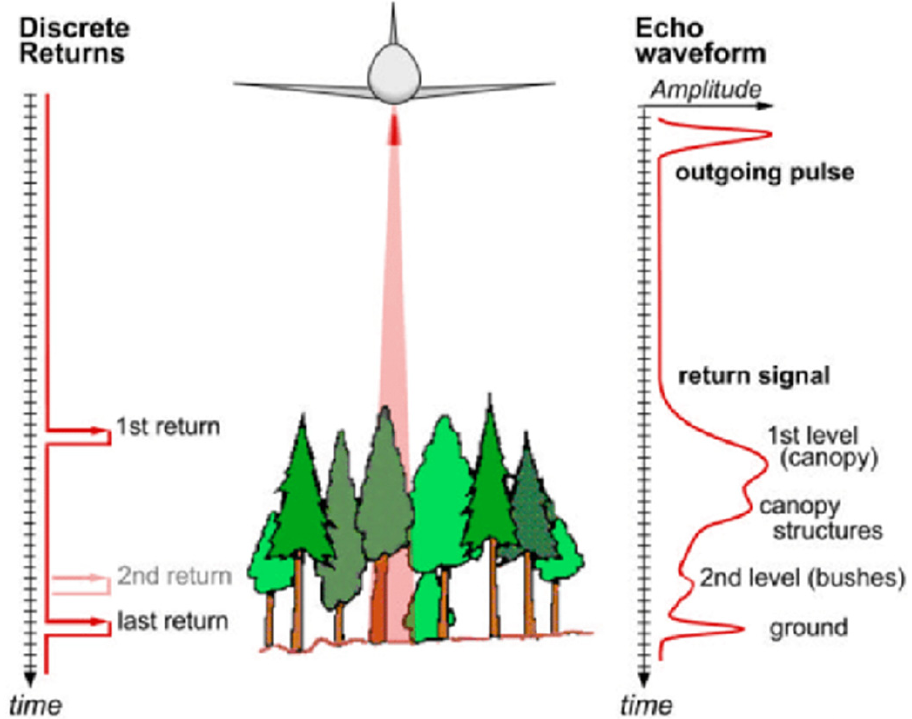
Figure 1. Illustration of laser beam outgoing and return signals (discrete and full-waveform) of LiDAR. Reprinted with permission from Ref. [9]. Copyright 2009 Ferraz, A.